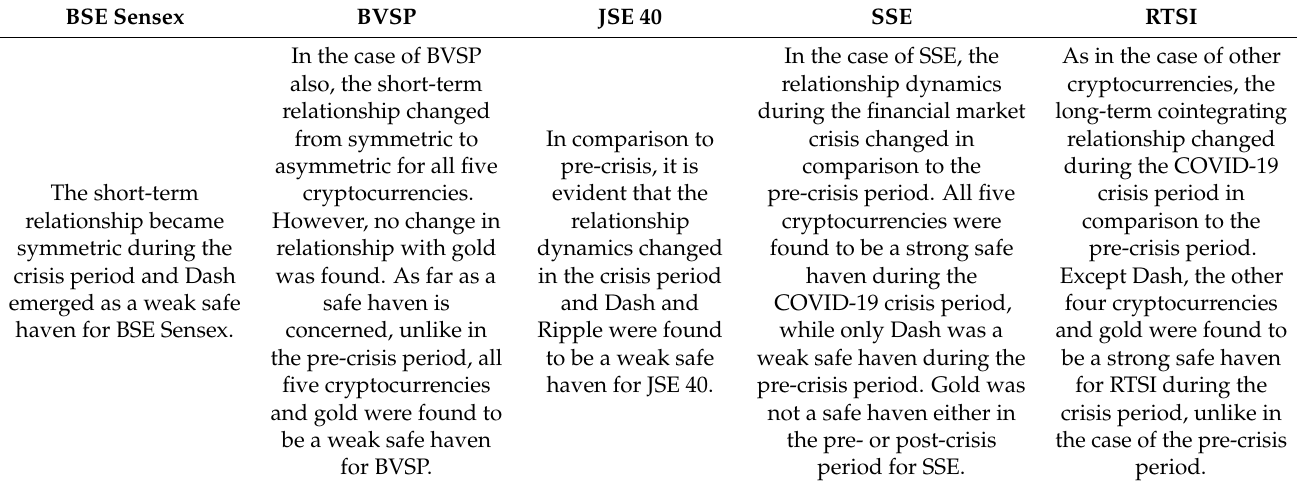
Table 15. Summary of the safe haven analysis.